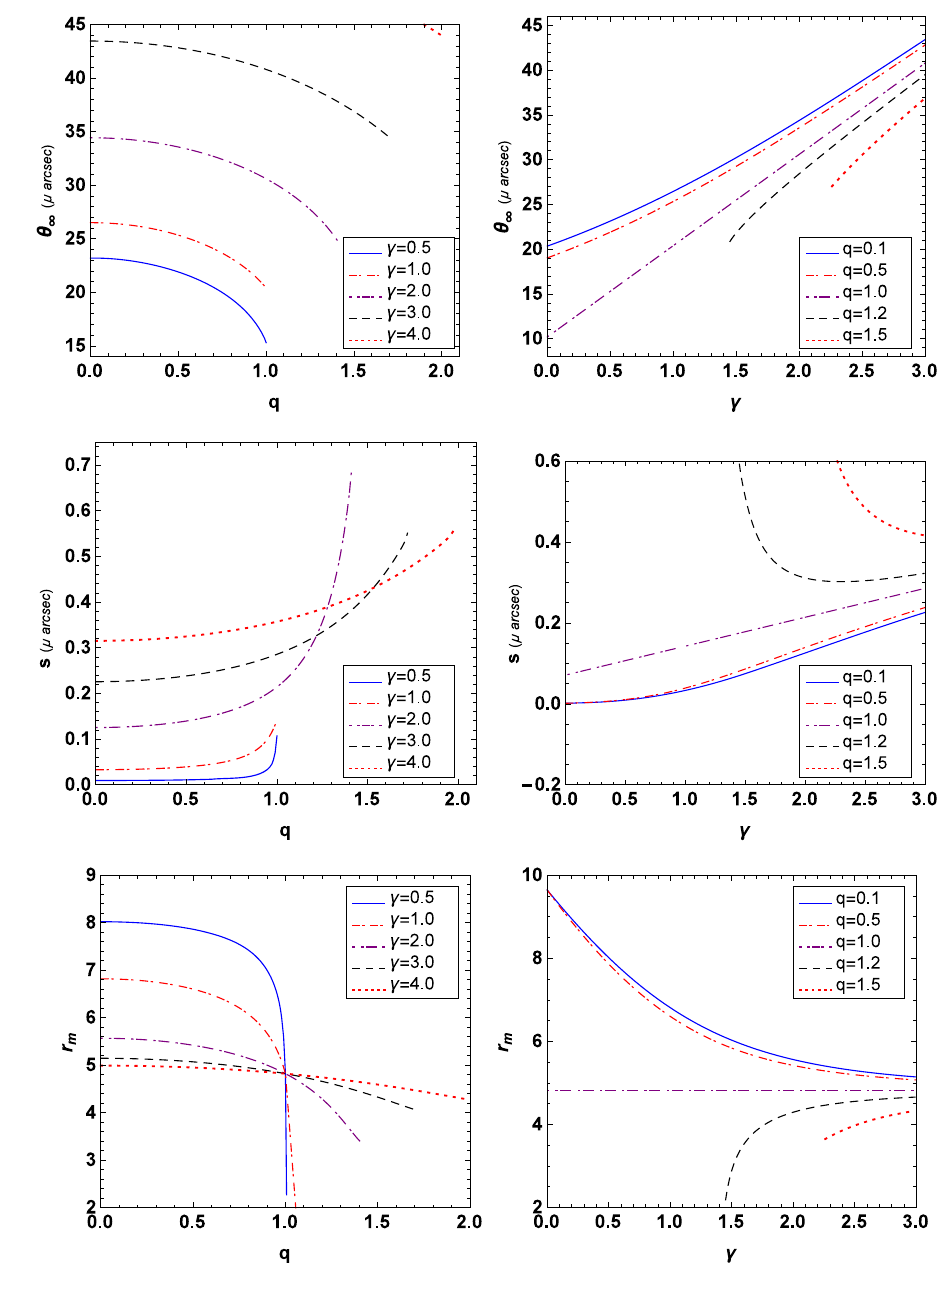
Fig. 7 Gravitational lensing by the center black hole in Milk Way Galaxy. Variation of the values of the angular position θ ∞ , the angular separation s , and the relative magnitudes r m with the parameters q and γ in the spacetime with torsion